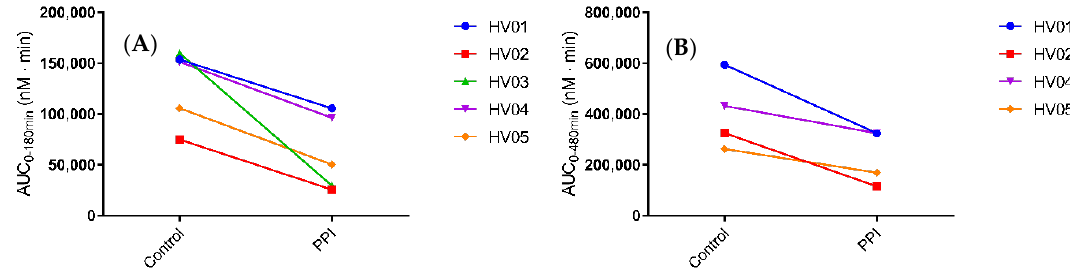
Figure 4. Systemic exposure to ritonavir in individual healthy volunteers (HV) after oral intake of a Norvir tablet in control vs. PPI condition, expressed as the area under the plasma concentration-time curve (AUC) ( A ) during the first 180 min (n = 5) and ( B ) during the full sampling period (480 min) period (n = 4).